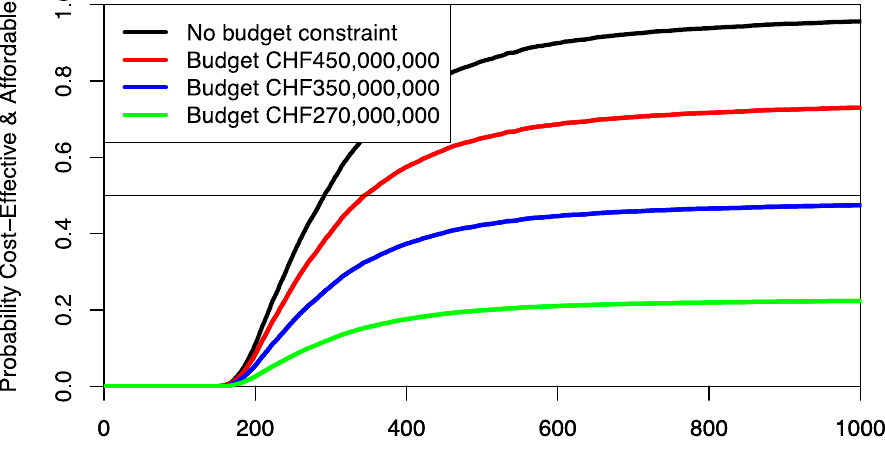
Figure 5. Incremental costs and effects of PALLET (palbociclib and letrozole) versus LET (letrozole) in patients with metastatic ER + HER2- breast cancer. The red line represents the ceiling ratio. The proportion of samples below the ceiling ratio represents the probability that PALLET is cost-effective at CHF 200,000 per QALY, which is 11%. One CHF (Swiss Franc) corresponds to $US 1.07.